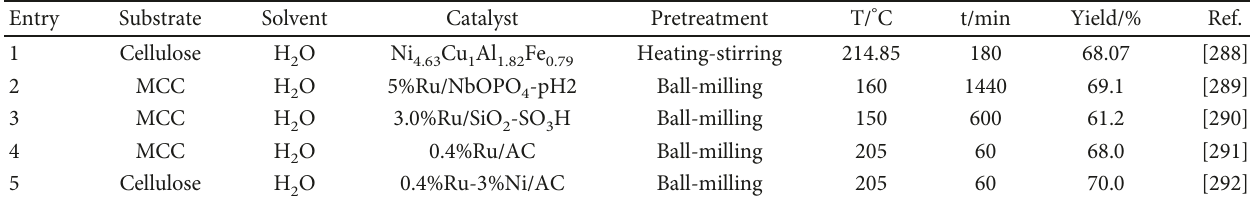
Table 4: Overview of sorbitol yields from the conversion of cellulose in the typical catalytic system.